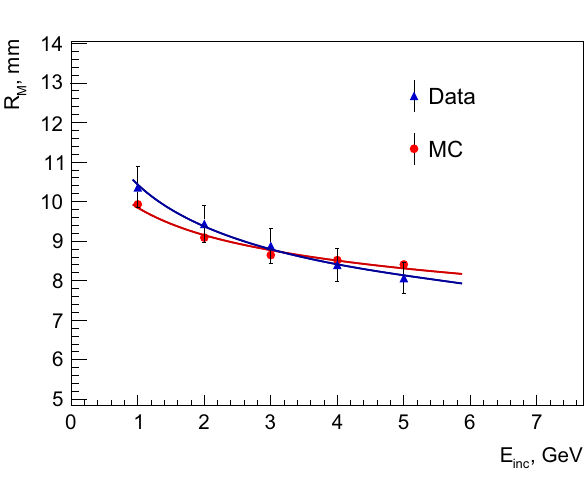
Fig. 23 Average transverse shower profiles for 1, 3 and 5 GeV elec- trons in data and the ratios between data and the fitted functions